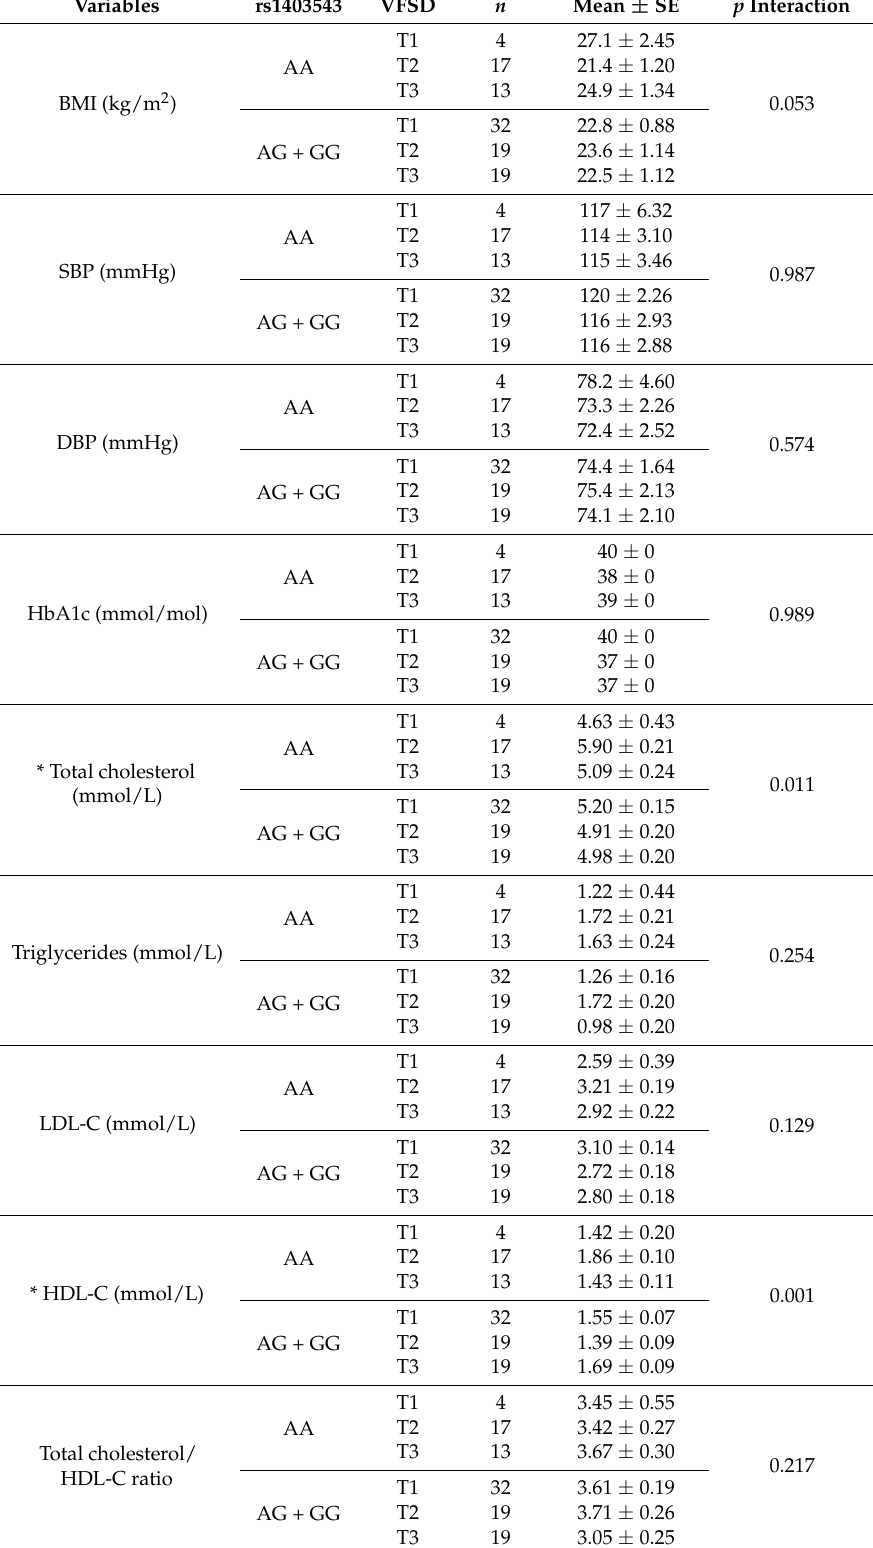
Table 7. Interaction between tertiles of “vegetables, fruit, and soy diet” (VFSD) and genotypes of the AGTR2 gene rs1403543 SNP on the metabolic risk factors of CVD in Chinese female